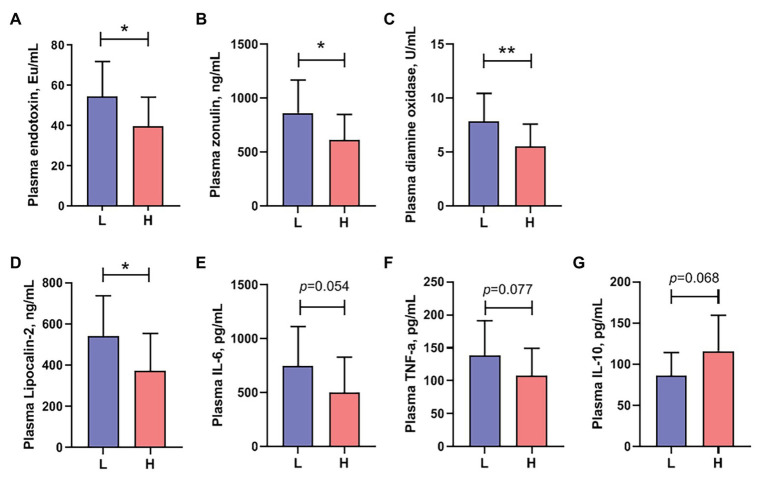
Plasma concentrations of (A) endotoxin, (B) zonulin, (C) diamine oxidase, (D) Lipocalin-2, (E) interleukin (IL)-6, (F) tumor necrosis factor (TNF)-α, and (G) IL-10 of different semen quality utilization rate group boars. Data are presented as mean ± SEM (n = 10 boars in the L group and 27 boars in the H group). *p < 0.05, **p < 0.01.